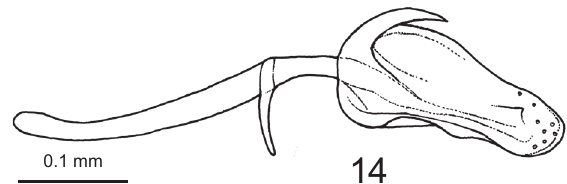
Figure 14. Pampsilota brandbergensis : Penis valve (left, lateral